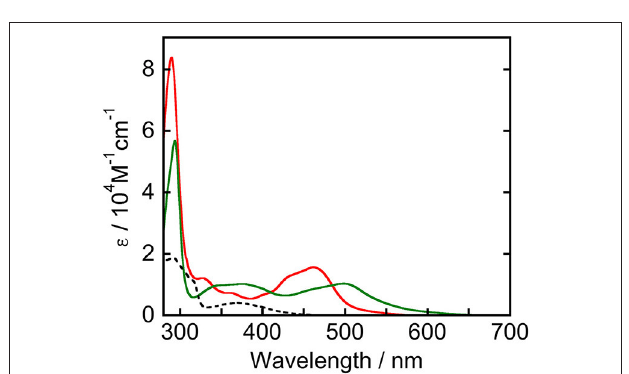
FIGURE 1 | UV-vis absorption spectra of Ru(pic) (green line), Ru(dmb) (red line), and Re (broken line) measured in a DMA solution.